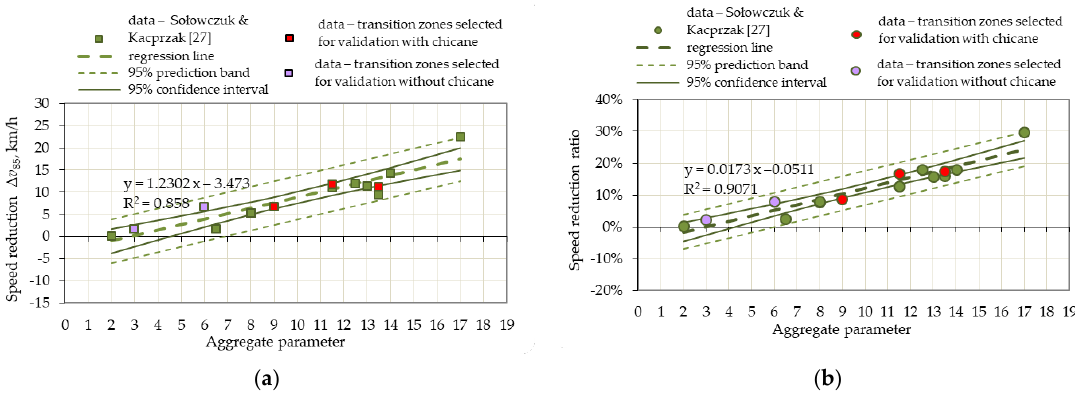
Figure 10. Linear regression function in the study area No. 2 defining the relationship between the aggregate parameter and speed reduction: ( a ) speed reduction ∆ v 85 ; ( b ) speed reduction ratio SRR. Source: own work of the authors.